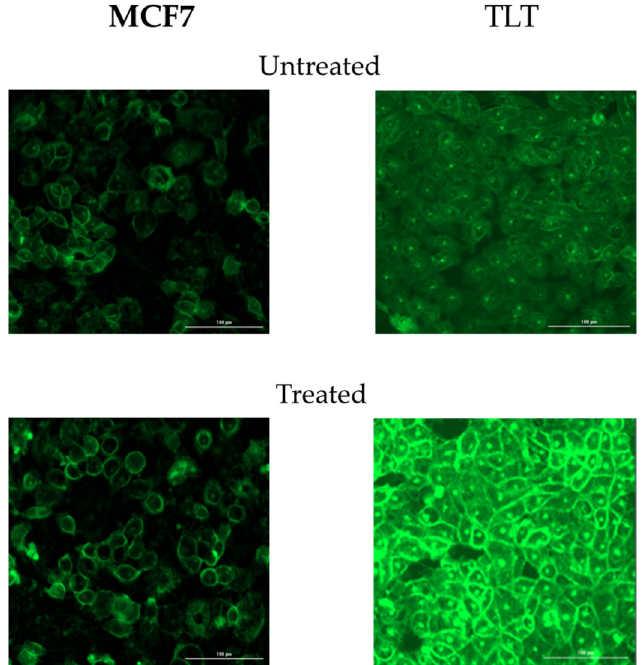
Figure A1. Fluorescence images of treated (12.5 nM peroxide) and untreated MCF7 and TLT cells.